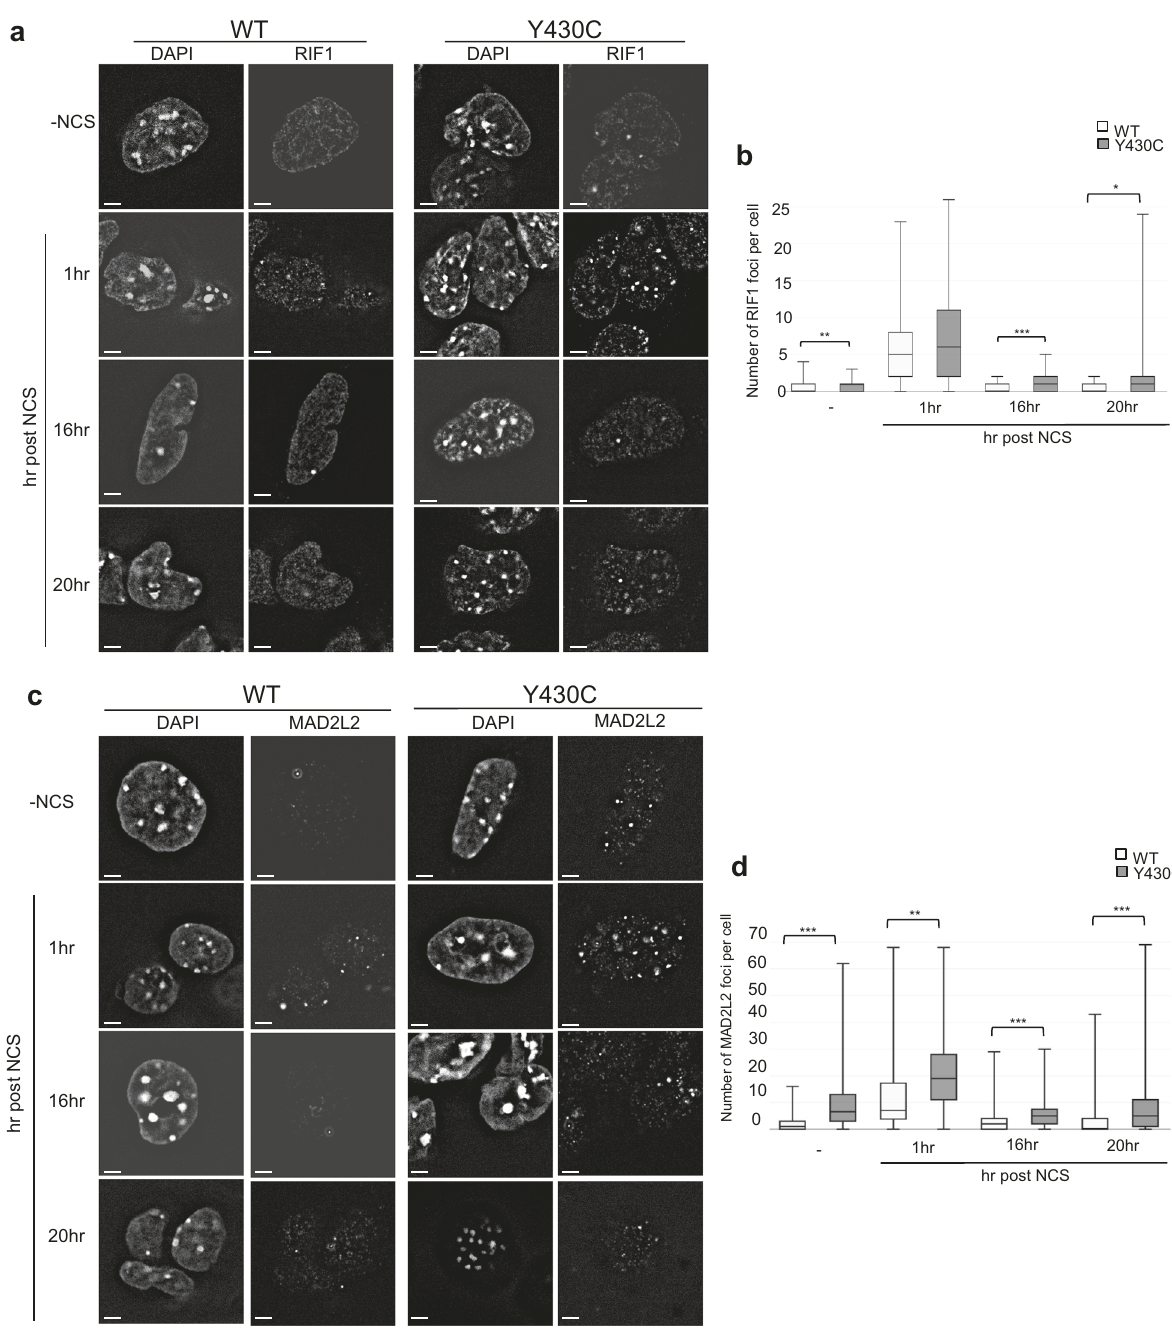
Fig. 5 Increased RIF1 and MAD2L2 foci after DSB induction in Y430C mESCs. a Representative images of wild-type and Y430C mESCs upon RIF1 immuno fl uorescence and DAPI staining after treatment with NCS. Scale bars: 2 μ m. The experiment was repeated three times with similar results. b Box- plot shows number of RIF1 foci per cell, respectively, in WT and Y430C cells after treatment with NCS in one representative experiment. Horizontal lines within boxes show medians, boxes are inter-quartile ranges and whiskers are range. P -values were calculated with Mann – Whitney one-sided U test. *<0.05, **<0.01, ***<0.001. 50 cells were examined per condition. c Representative images of wild-type and Y430C mESCs upon MAD2L2 immuno fl uorescence and DAPI staining after treatment with NCS. Scale bars: 2 μ m. The experiment was repeated three times with similar results. d Box- plot shows number of MAD2L2 foci per cell, respectively, in WT and Y430C cells after treatment with NCS in one representative experiment. Horizontal lines within boxes show medians, boxes are inter-quartile ranges and whiskers are range. P -values were calculated with Mann – Whitney one-sided U test. *<0.05, **<0.01, ***<0.001. 50 cells were examined per